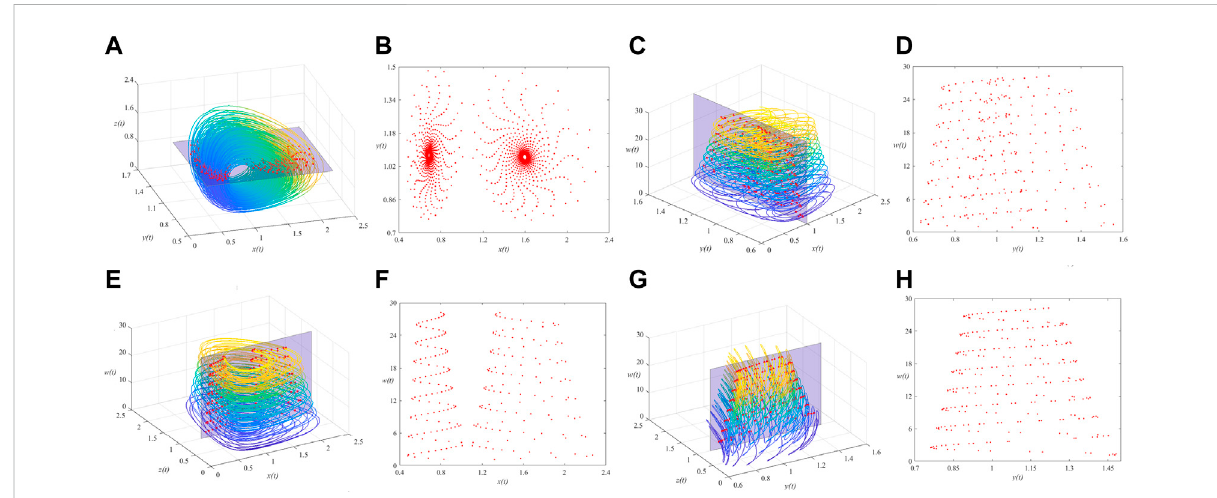
FIGURE 6 3D view of the MSMFrLVS and the Poincare section in: (A,B) : x - y - z space, (C,D) : x - y - w space, (E,F) : x-z-w space, (G,H) : y-z-w